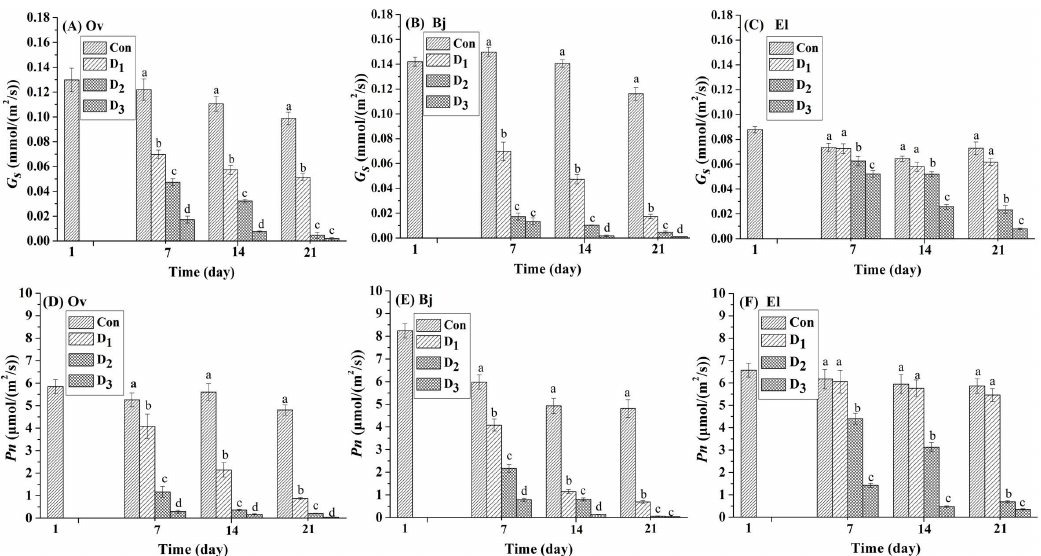
Figure 2. Effect of different levels (Con: 25% moisture, D 1 : 17% moisture, D 2 : 14% moisture, and D 3: 11% moisture) of drought stress on P n (net photosynthetic rate, ( µ mol · m 2 · s − 1 )) and G s (stomatal conductance ( G s (mmol · m 2 · s − 1 )) in the leaves of the three plant species. The different letters above the bars represent significant differences among treatments on the same day ( p < 0.05). ( A – C ): G s of Orychophragmus violaceus L. (Ov); Brassica juncea L. (Bj); and Euphorbia lathyris L. (El); ( D – F ): P n of Orychophragmus violaceus L. (Ov); Brassica juncea L. (Bj); and Euphorbia lathyris L.